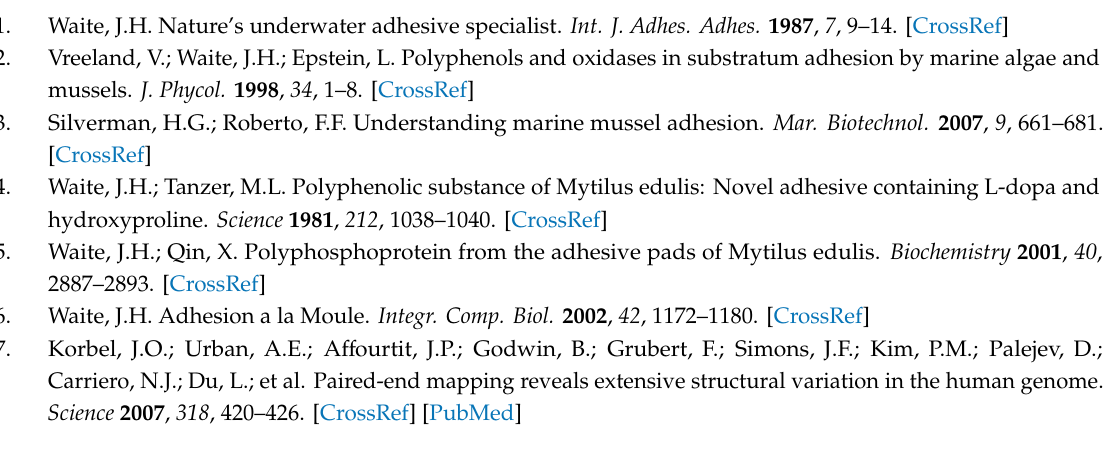
Figure S1: XPS spectra of the ABS surface before and after plasma treatment, Figure S2: Results of XPS analysis of the glass surface before and after PDA coating, Figure S3: Calibration curve for calculating the amount of Pt on Pt / ABS samples, and Figure S4: Calibration curve for calculating the H 2 O 2